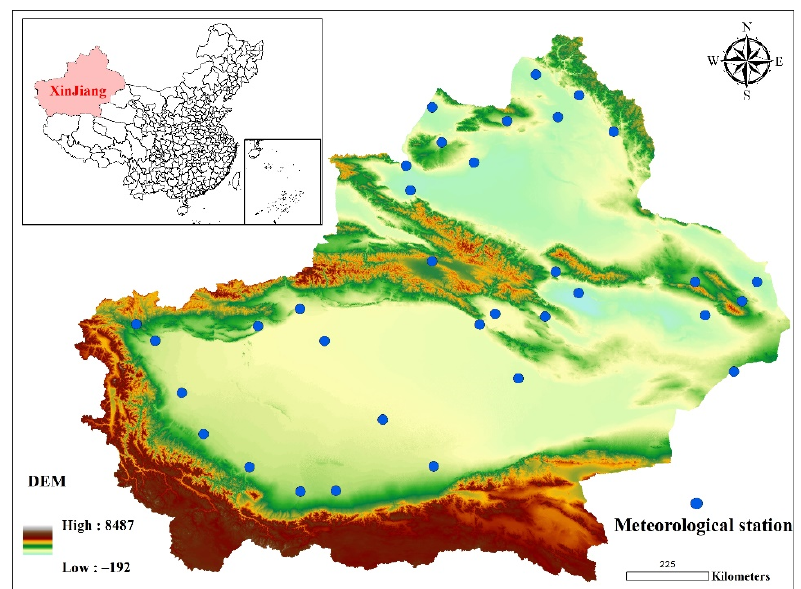
Figure 1. Location of the study area (the small picture inserted shows the geographical location of Xin-jiang).